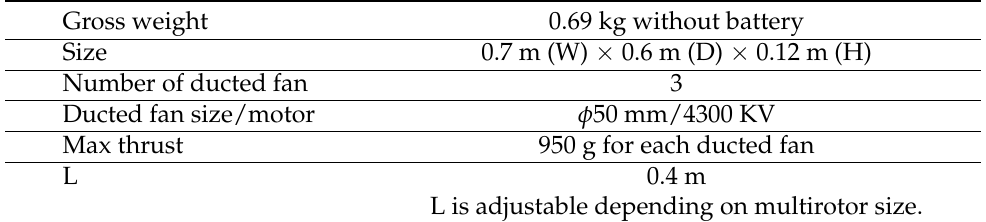
Figure 2. ( a ) Overview of ATD and its defined parameters; and ( b ) the model of ATD. The blocked region shows feasible control force volume and parameters corresponding to ( a ). The coordination is defined as the same as the body frame of multirotor. Table 1. Specifications of